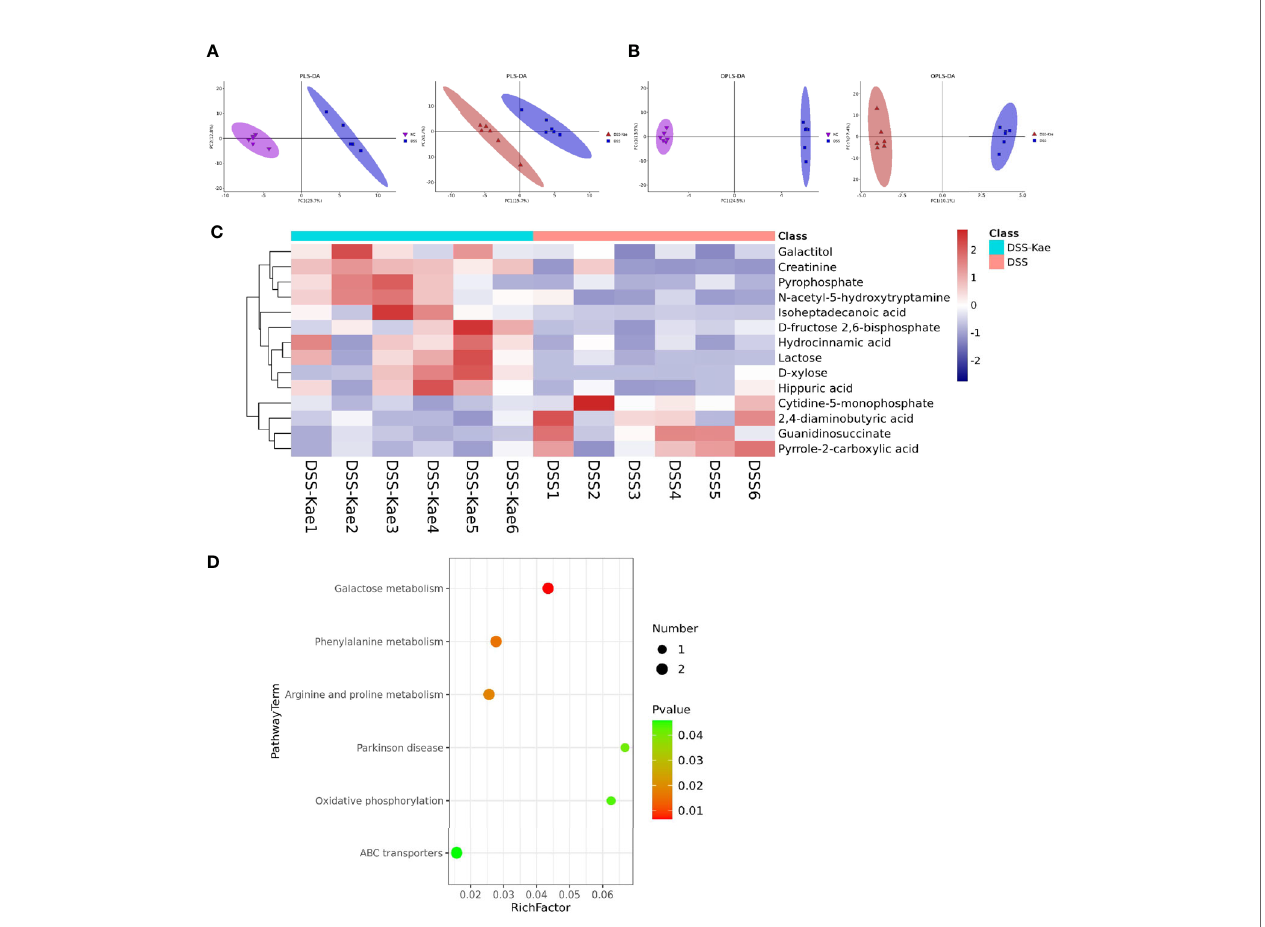
FIGURE 6 | Kae altered fecal metabolic composition. (A) PLS-DA analysis score plot showing comparisons of the NC vs DSS and DSS vs DSS-Kae group metabolome pro fi les. (B) OPLS-DA analysis score plots showing comparisons of the NC vs DSS and DSS vs DSS-Kae group metabolome pro fi les. (C) Heat map showing metabolites differing signi fi cantly in abundance between the DSS and DSS-Kae groups. (D) KEGG pathway analysis of the DSS and DSS-Kae groups. Statistical analysis was conducted by calculation of Pearson correlation coef fi cients (VI P > 1 and P <